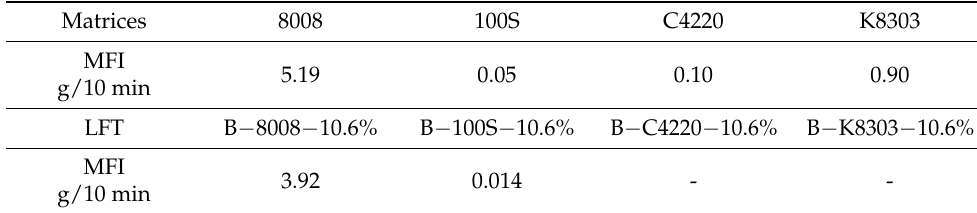
Table 2. MFI values of the neat matrices and the corresponding LFT composites.